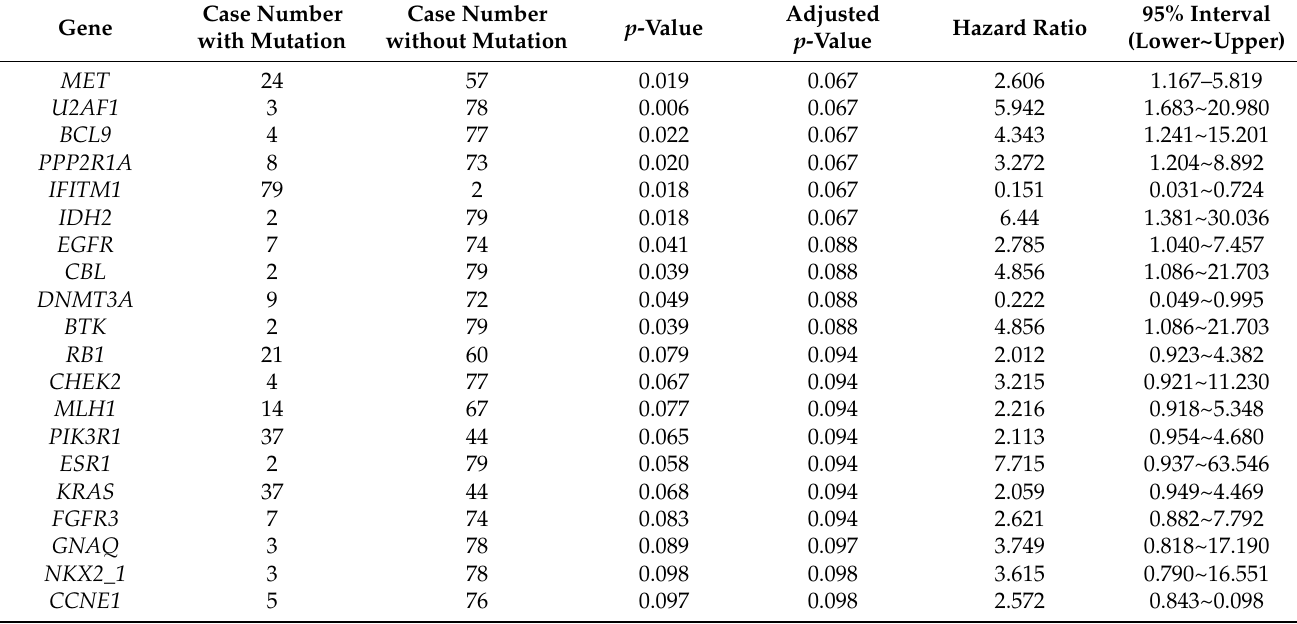
Table 1. The association between the mutated genes and overall